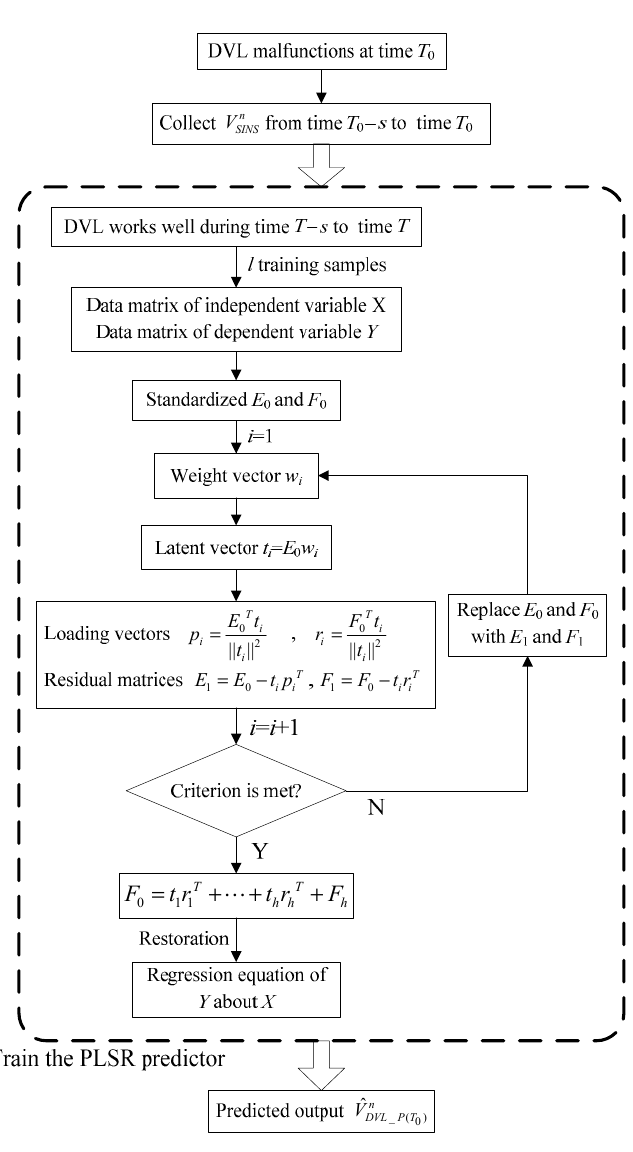
Figure 3. The prediction based on PLSR.